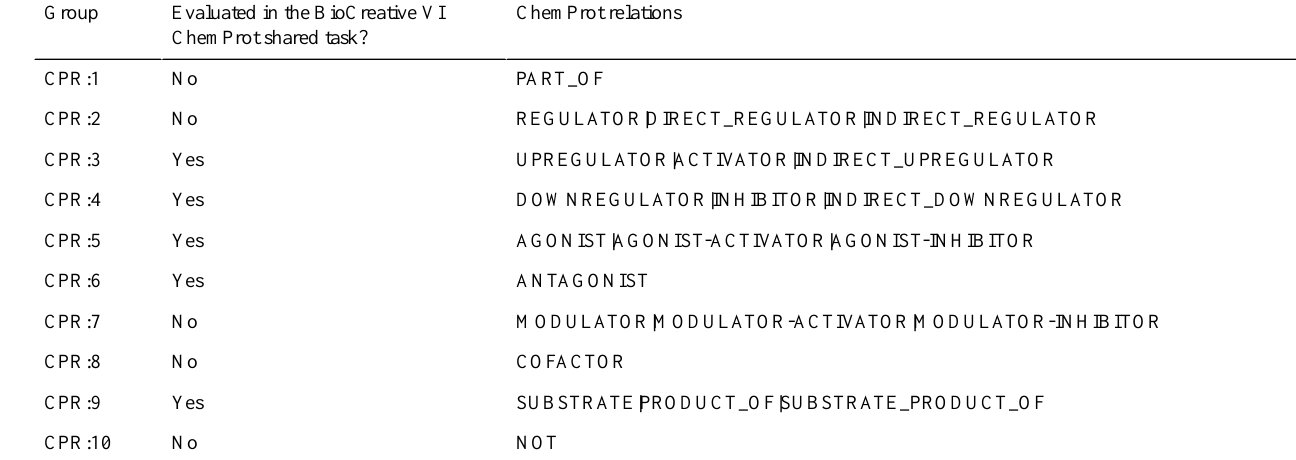
Table 2. Statistics of the ChemProt corpus.